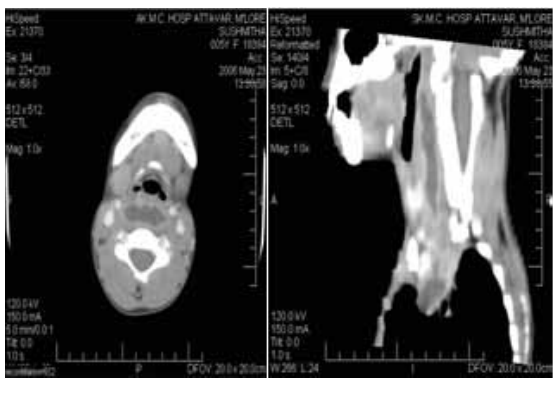
Figure 1. Prevertebral abscess extending from the level of oropharynx upto the mediastinum inferiorly